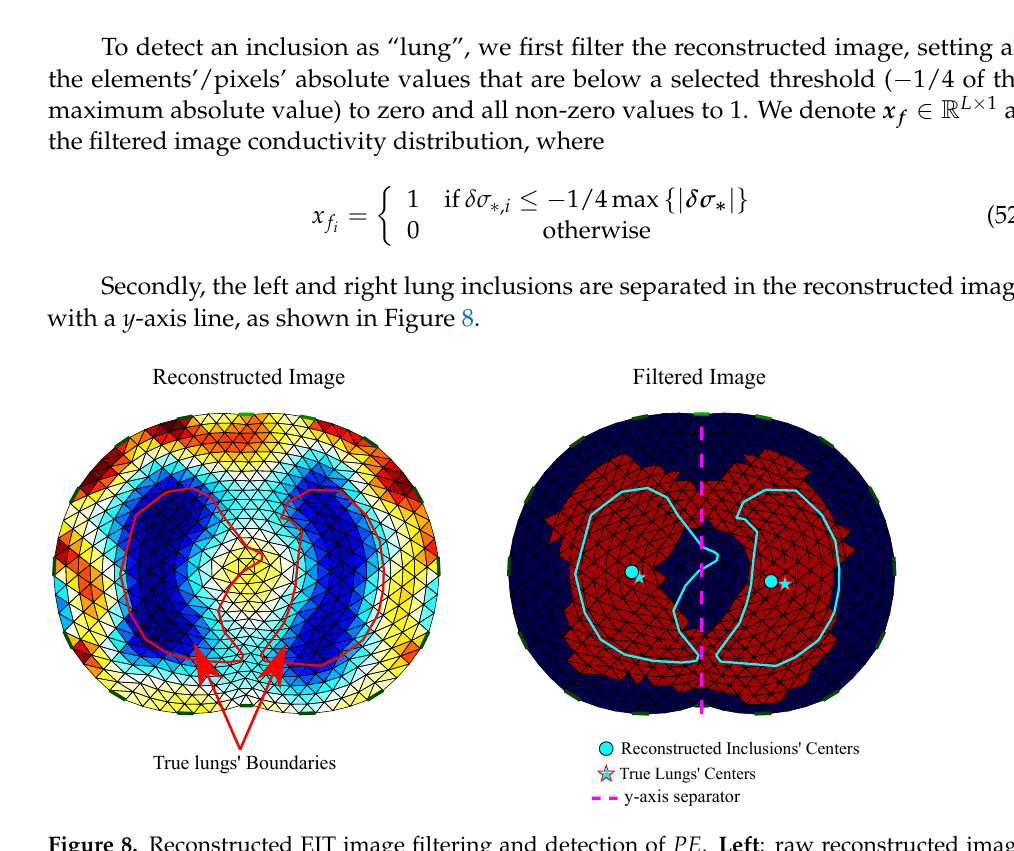
Figure 8. Reconstructed EIT image filtering and detection of PE . Left : raw reconstructed image including the true lungs’ boundaries (for the corresponding 3 D model’s cross-section). Right : filtered image including true and reconstructed lungs’